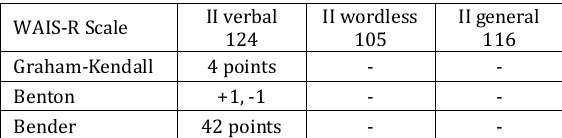
Table 1. Accounted results of the scales: WAIS-R and